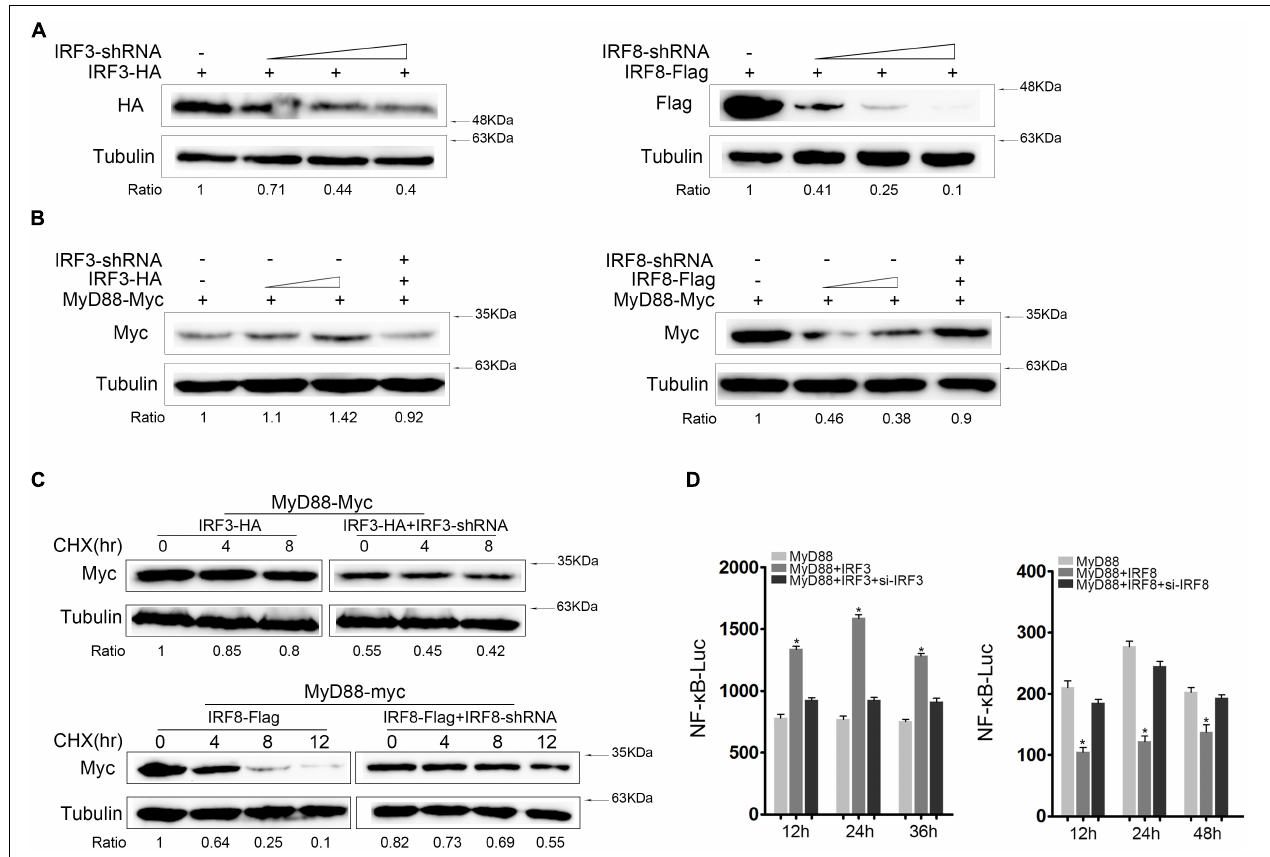
FIGURE 4 | Knockdown of IRF3 or IRF8 regulate MyD88-mediated NF- κ B activation. (A) HEK293 cells were cotransfected with the 0.4 µ g of IRF3 or 0.4 µ g of IRF8 plasmids with different concentrations of IRF3-shRNA (0.1, 0.2, or 0.4 µ g) or IRF8-shRNA (0.1, 0.2, or 0.4 µ g), respectively. After 24 h post transfection, IRF3 or IRF8 was determined by immunoblot assays. (B) HEK293 cells were seeded in 12-well plates and cotransfected with the IRF3 (0.2 or 0.4 µ g) or IRF8 (0.2 or 0.4 µ g) plasmids together with 0.4 µ g of MyD88 and then 0.4 µ g of IRF3 or IRF8 plasmid in the fourth well with 0.4 µ g of IRF3-shRNA or IRF8-shRNA, respectively, together with 0.4 µ g of MyD88. MyD88 was determined by immunoblot assays. (C) HEK293 cells were seeded in 12-well plates and cotransfected with 0.4 µ g of IRF3 and IRF3-shRNA plasmids or IRF8 and IRF8-shRNA plasmids, respectively, together with 0.4 µ g of MyD88. At 24 h post transfection, and cells were treated with CHX (100 µ g/ml) and lysed at different time points. The expression of MyD88 was examined by immunoblot assays. (D) EPC cells were seeded in 24-well plates and cotransfected with 0.2 µ g of IRF3 plasmid and IRF3-siRNA or 0.2 µ g of IRF8 plasmid and IRF8-siRNA, respectively, together with 0.1 µ g of MyD88 and 0.25 µ g of NF- κ B reporter gene, and the luciferase activity was measured at different times.* p < 0.05 versus the controls. All experiments were performed in at least three independent